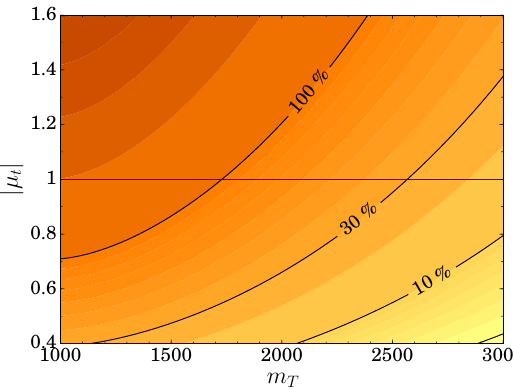
Figure 4. Ratio of signal over background s = b